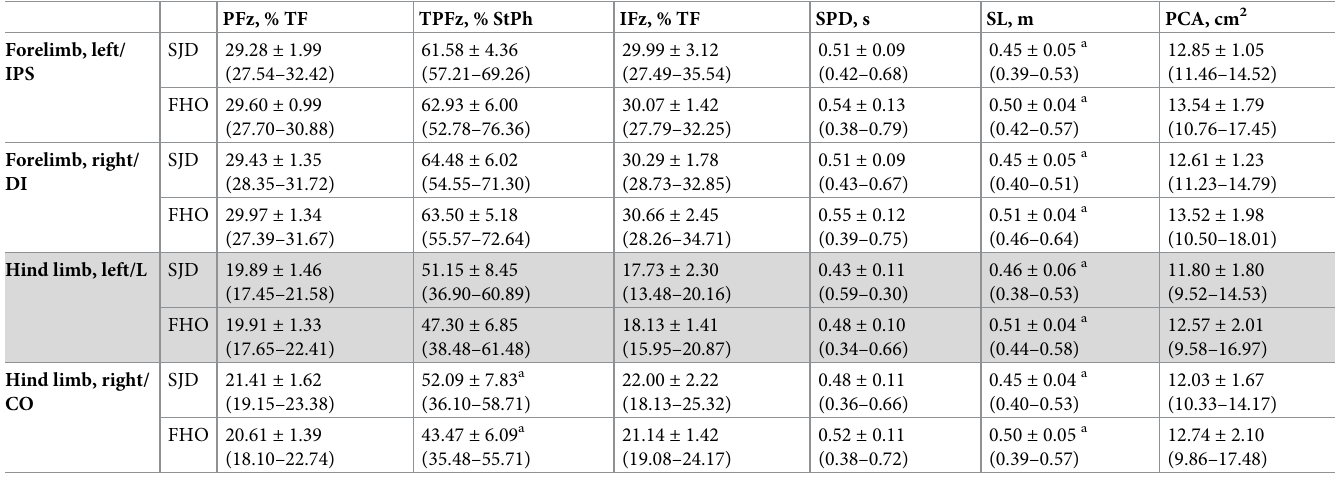
Table 3. Ground reaction forces (normalized to %TF) and temporospatial parameters in 7 cats with stifle joint disease and 13 after FHO. Forelimb, left/